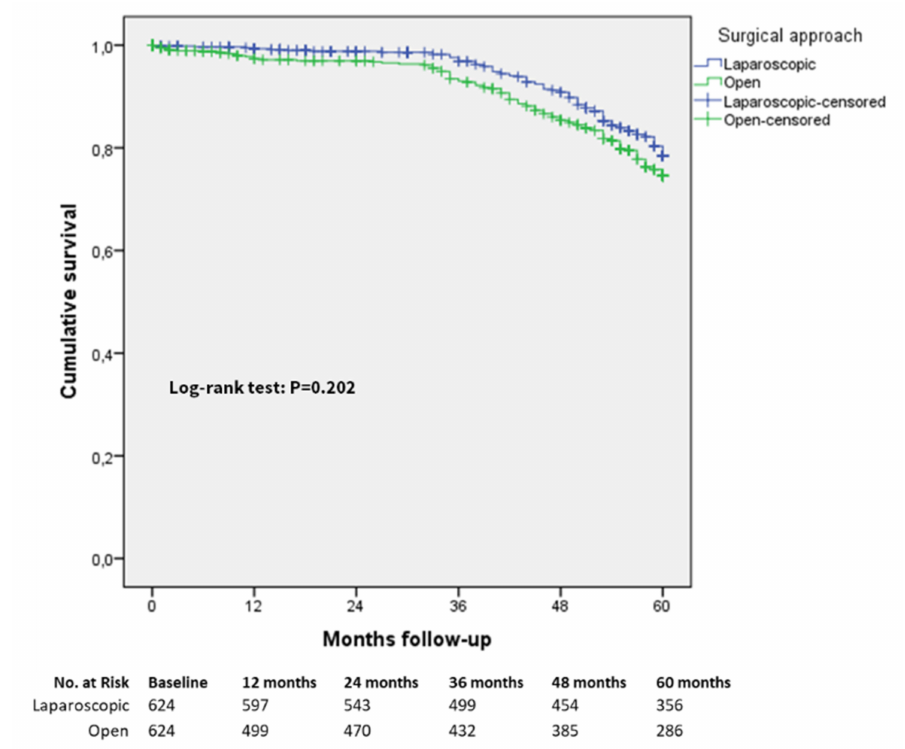
Figure 2. Five-year overall survival, matched cohort (all